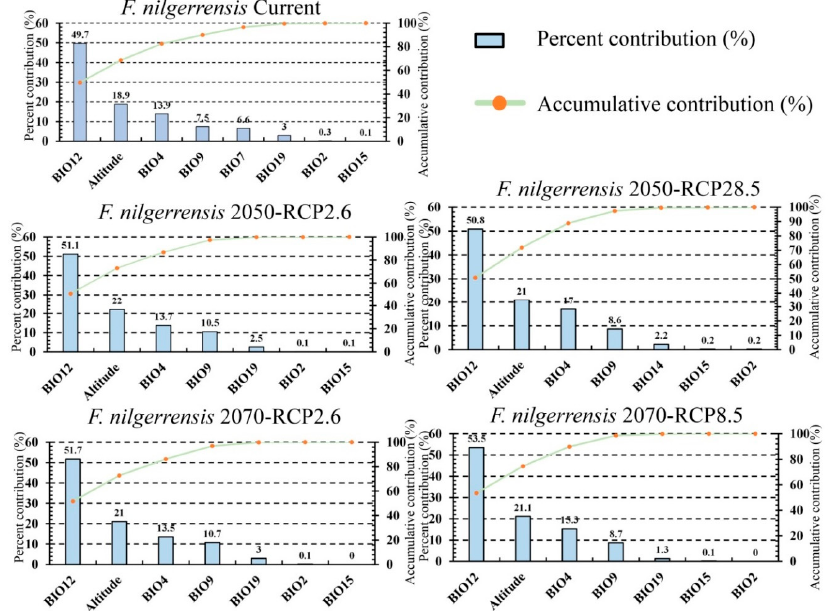
Figure 2. Effects of the selected environmental variables on the distribution of F. nilgerrensis and their percent and accumulative contributions under five climate scenarios. “Current” represents current scenario (1970 to 2000), “RCP2.6” represents the minimum greenhouse gas scenario, and “RCP8.5” represents the maximum greenhouse gas scenario; “2050” and “2070” represent two periods of the 2050s (2041 to 2060) and 2070s (2061 to 2080), respectively. BIO2, mean diurnal range; BIO4, temperature seasonality; BIO7, temperature annual range; BIO9, mean temperature of driest quarter; BIO12, annual precipitation; BIO14, precipitation of driest month; BIO15, precipitation seasonality; BIO19, precipitation of coldest